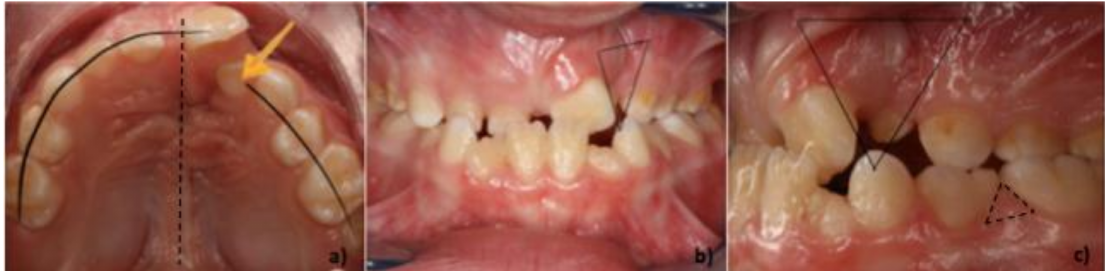
Figure 1. Intraoral photographs of a child with cleft lip and palate, Spina type II (complete cleft lip and palate on the left side): ( a ) collapse of the lateral segments of the maxilla (dashed line, medial sagittal plane), the arrow shows a supernumerary tooth in the cleft area; ( b ) frontal photograph and ( c ) left lateral photograph—space of triangular shape, with vertex towards occlusal and the base of the triangle towards to the cleft; and ( c ) the triangular shape of the cleft is similar to those of the tooth niches (dashed